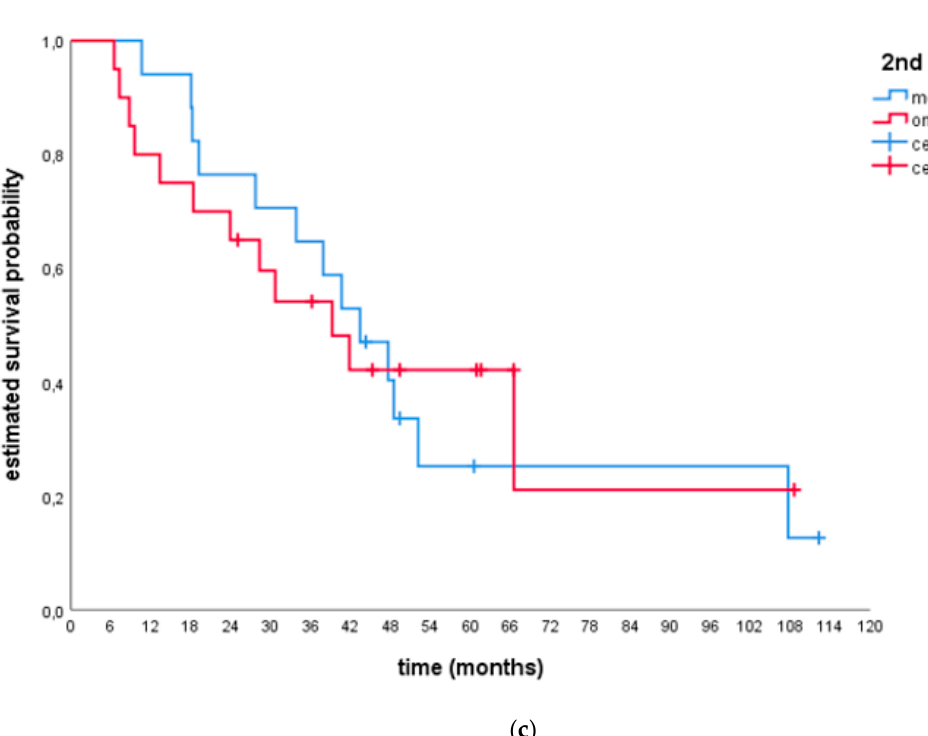
Figure 1. ( a ) Duration on treatment of ALK positive patients. ( b ) Overall Survival (OS) of ALK positive patients since start of lorlatinib treatment. ( c ) Comparison of OS since date of locally advanced or metastatic diagnosis between the two subgroups (only one prior second generation TKI or more).